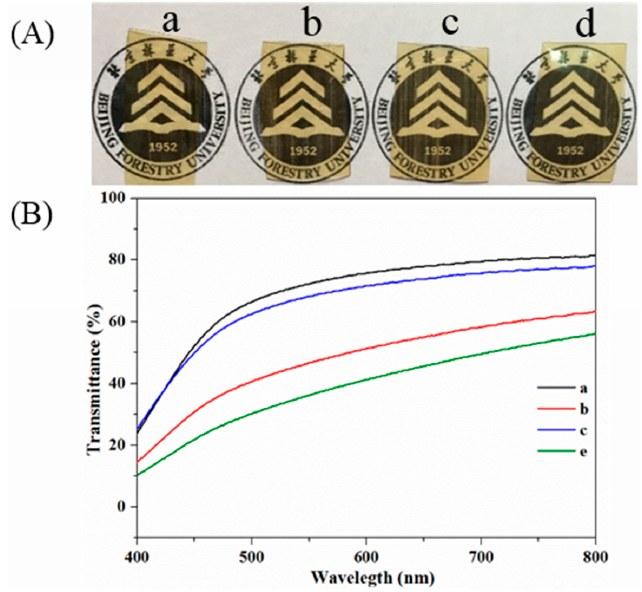
Figure 8. Photographs ( A ) and UV-Vis spectra ( B ) of the SPI-based films: SPI and PTGE film a ; SPI, PTGE, and HNTs film b ; SPI, PTGE, and CMCS film c ; SPI, PTGE, HNTs, and CMCS film d .